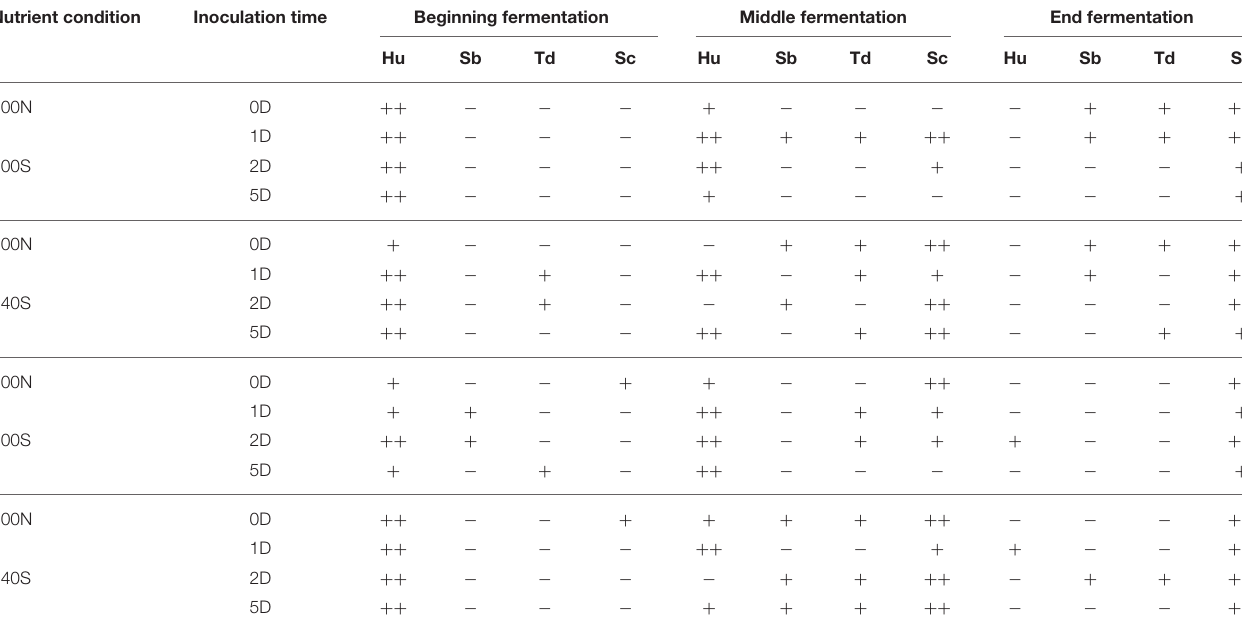
TABLE 3 | Results of the DGGE-PCR for H. uvarum (Hu), S. bacillaris (Sb), T. delbrueckii (Td) and S. cerevisiae (Sc) expressed as “ ++ ” (the intensity of the band detected by DGGE gel was high), “ + ” (the intensity of the band detected by DGGE gel was weak) and “ − ” (no band was detected by DGGE gel). Nutrient